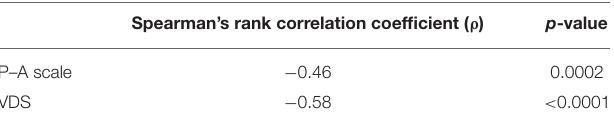
TABLE 4 | Spearman’s rank correlation coefficients between the Neuromuscular Disease Swallowing Status Scale and videofluorographic swallowing